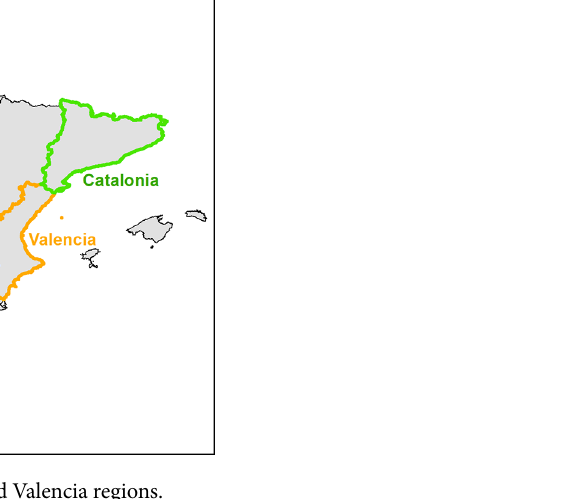
Figure 1. Location of the Catalonia and Valencia